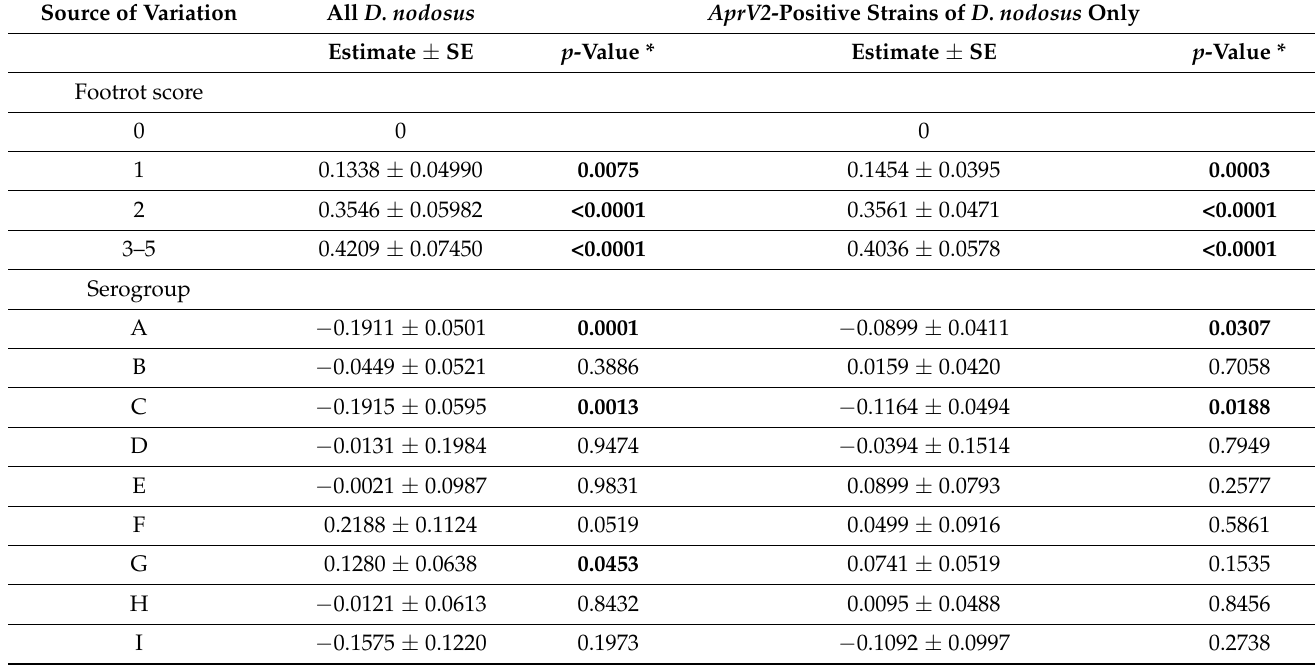
Table 7. Source of variation, effect estimates with their standard errors (SE) and p -values for loads of all and aprV2 -positive strains of D. nodosus from the mixed linear multivariable model. All D.